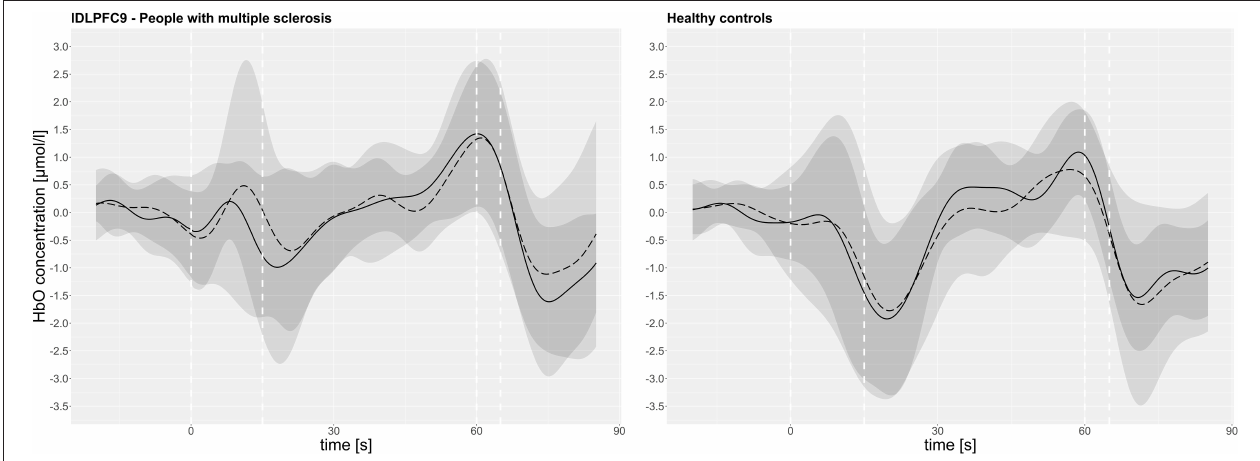
FIGURE 3 | The oxyhemoglobin concentration (HbO) in the left dorsolateral prefrontal cortex Brodmann area 9 (lDLPFC9) of all subjects (mean pre: continuous line, post: dashed line/standard deviation pre: dark gray, post: light gray) over the course of measurement intervals. The dashed white vertical line represents: 0s = start of the treadmill, 15s = start of dual-task walking, 60s = treadmill stopped, 65s = start of the baseline.